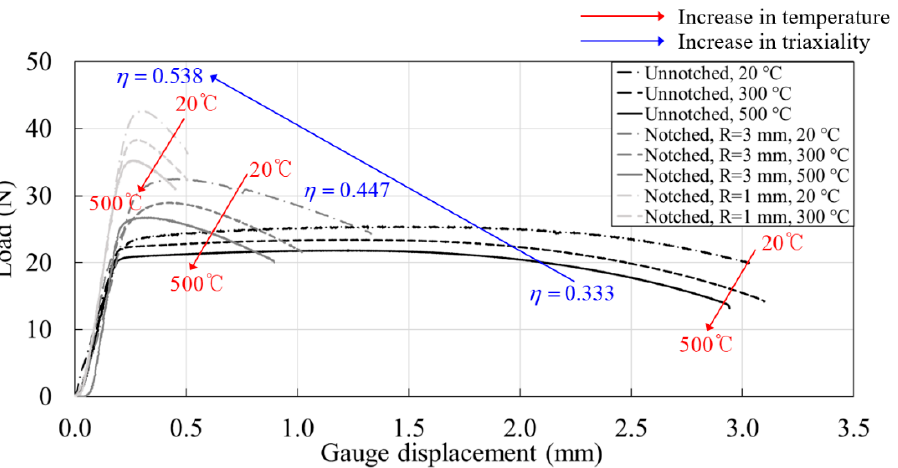
Figure 9. Load–displacement curves of the tensile experiments for the unnotched and notched specimens at 20, 300, and 500 ◦ C environmental temperatures.